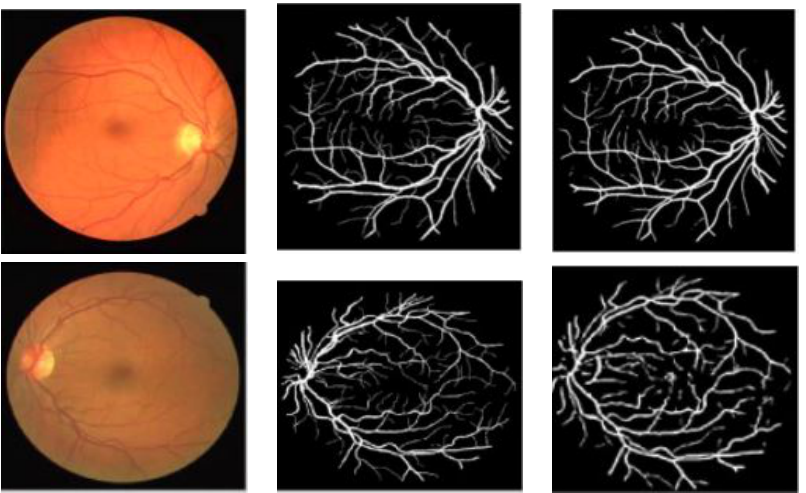
Figure 4. Retinal blood vessel segmentation results on the DRIVE dataset using [75,76] methods, respectively. Left: Original Image. Middle: Ground-truth, Right: Segmentation Result.